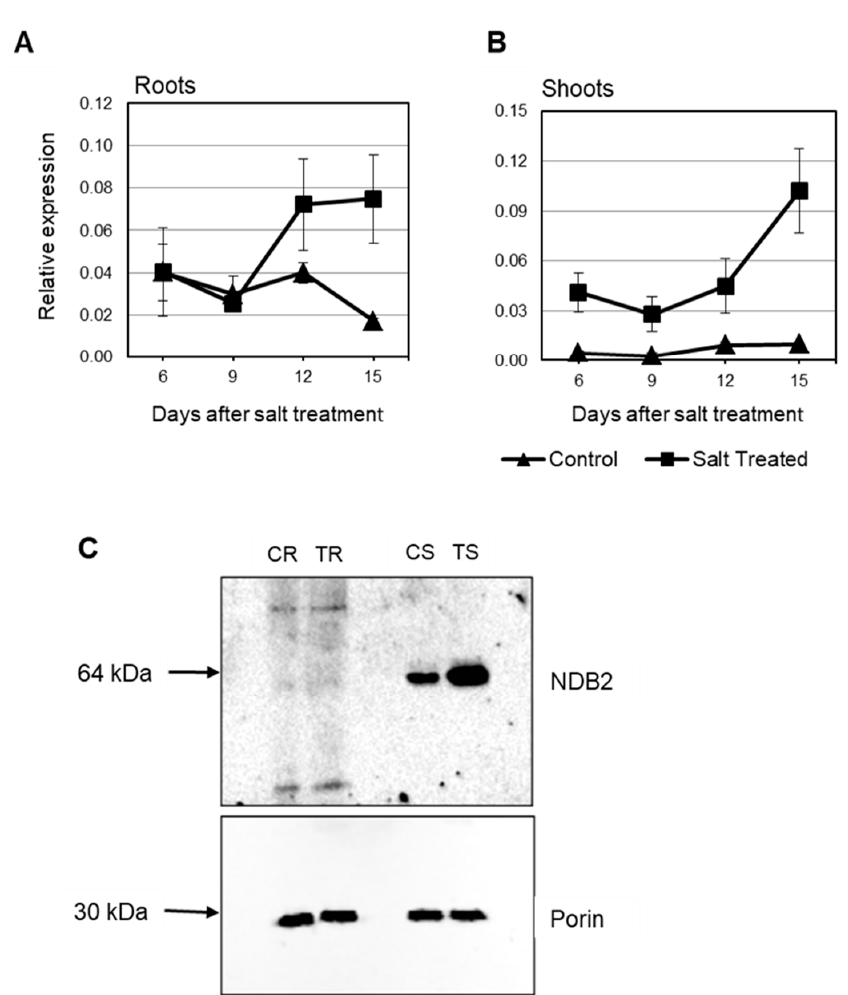
Figure 9. Expression of OsNDB2 in rice under salt stress. Expression was analysed in seedling roots ( A ) and shoots ( B ) exposed to 120 mM NaCl over the period of 15 days using qRT-PCR. Data are shown as the mean relative gene expression ± SE of three biological replicates; ( C ). An immunoblot of the OsNDB2 protein present in mitochondria isolated from salt-treated and control shoots harvested 9 days after the start of salt application. CR-control roots; TR-treated roots; CS-control shoots; TS-treated shoots.